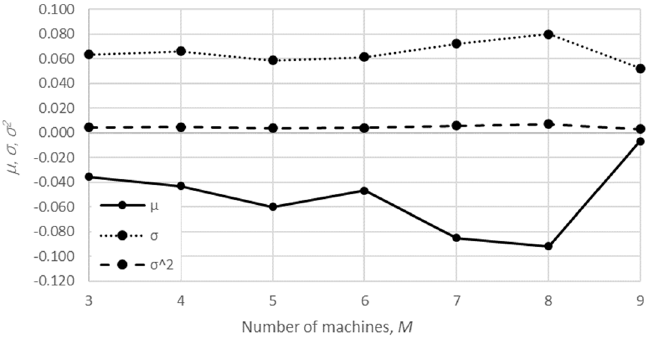
Figure 20. The relative error of the PR concerning the number of machines—numerical method.